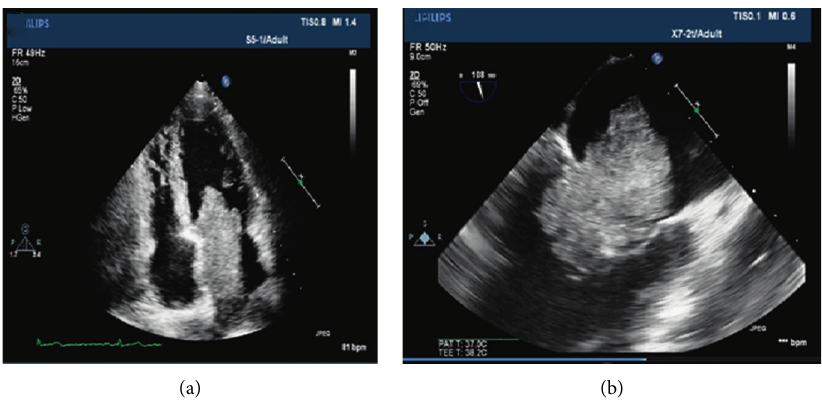
Figure 1: Transthoracic echocardiogram showing a large mass attached to the interatrial septum (a). The mass has a broad stalk and protrudes into the left ventricle during diastole and almost completely occludes the mitral valve